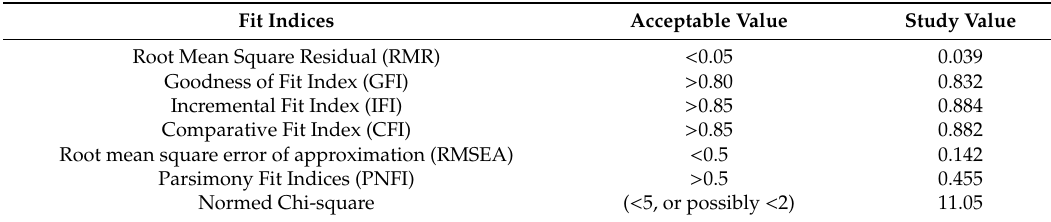
Table 3. Model fit indices.